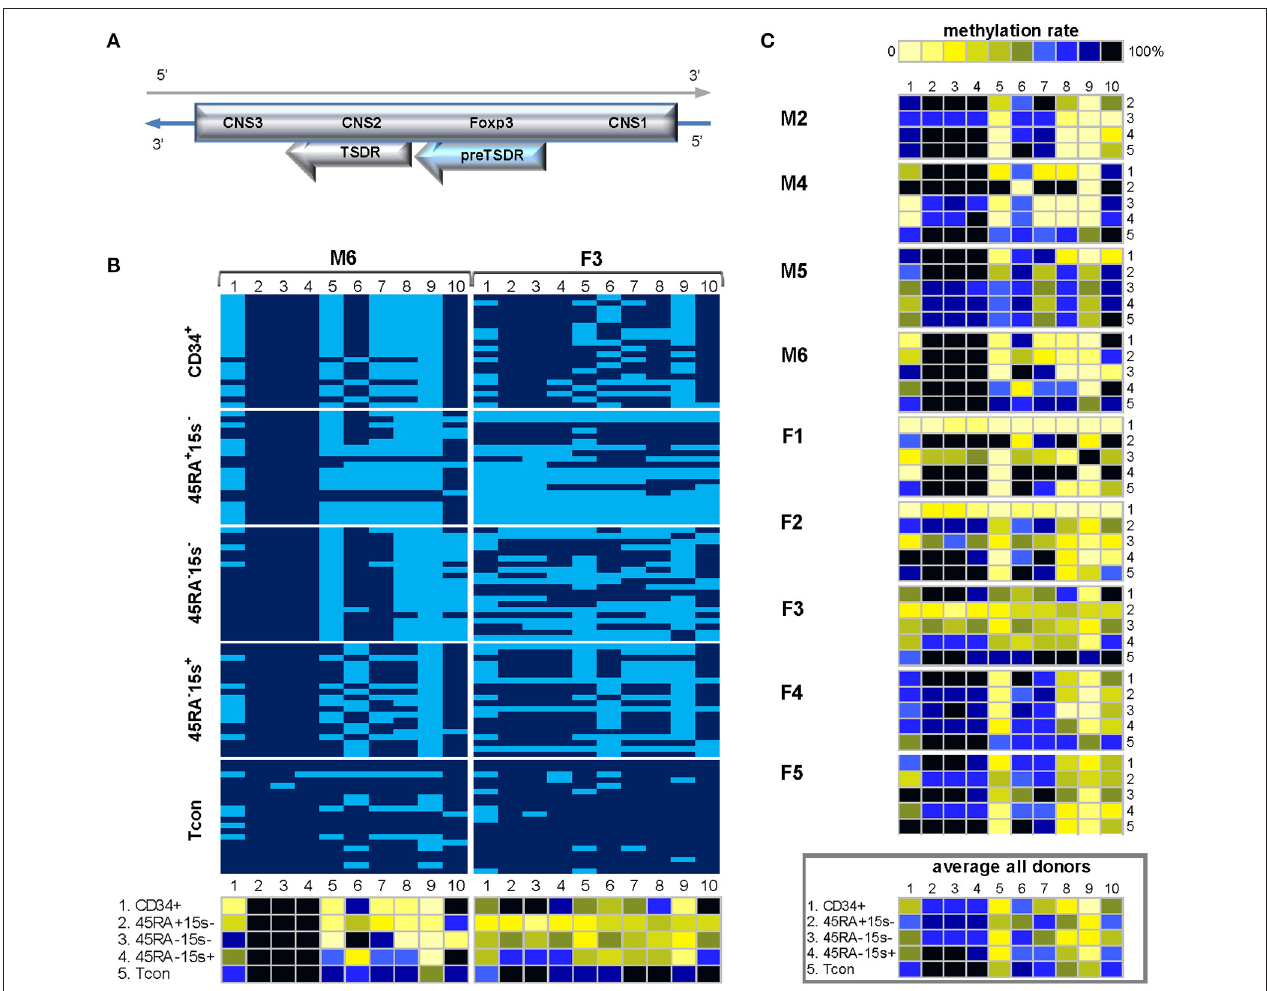
FIGURE 5 | Methylation pattern of FOXP3 preTSDR region. CpG positions 1, 5, 8, and 9 within FOXP3 preTSDR show a certain degree of hypomethylation in CD34 + cells and Treg subtypes as compared to Tcon cells. (A) Schematic presentation of the FOXP3 preTSDR encoded in the reverse strand of Xp11.23. (B). Methylation pattern of the FOXP3 preTSDR in five cell populations: CD34 + (1), CD45RA + CD15s − (2), CD45RA − CD15s − (3), CD45RA − CD15s + (4), and Tcon (5) of donors M6 and F3. CpGs 1-10 are numbered relative to the 5 ′ -3 ′ direction of the coding (reverse) strand. Each horizontal line represents DNA from one cell with unmodified C in light blue and m C in dark blue. Methylation percentage for each CpG site was calculated based on the number of m Cs in a total of 20 and summarized in panels below. (C) Methylation patterns of the FOXP3 preTSDR of individual donors with the average methylation pattern for all donors presented in the panel below. See also Supplementary Figures 1 , 4 .